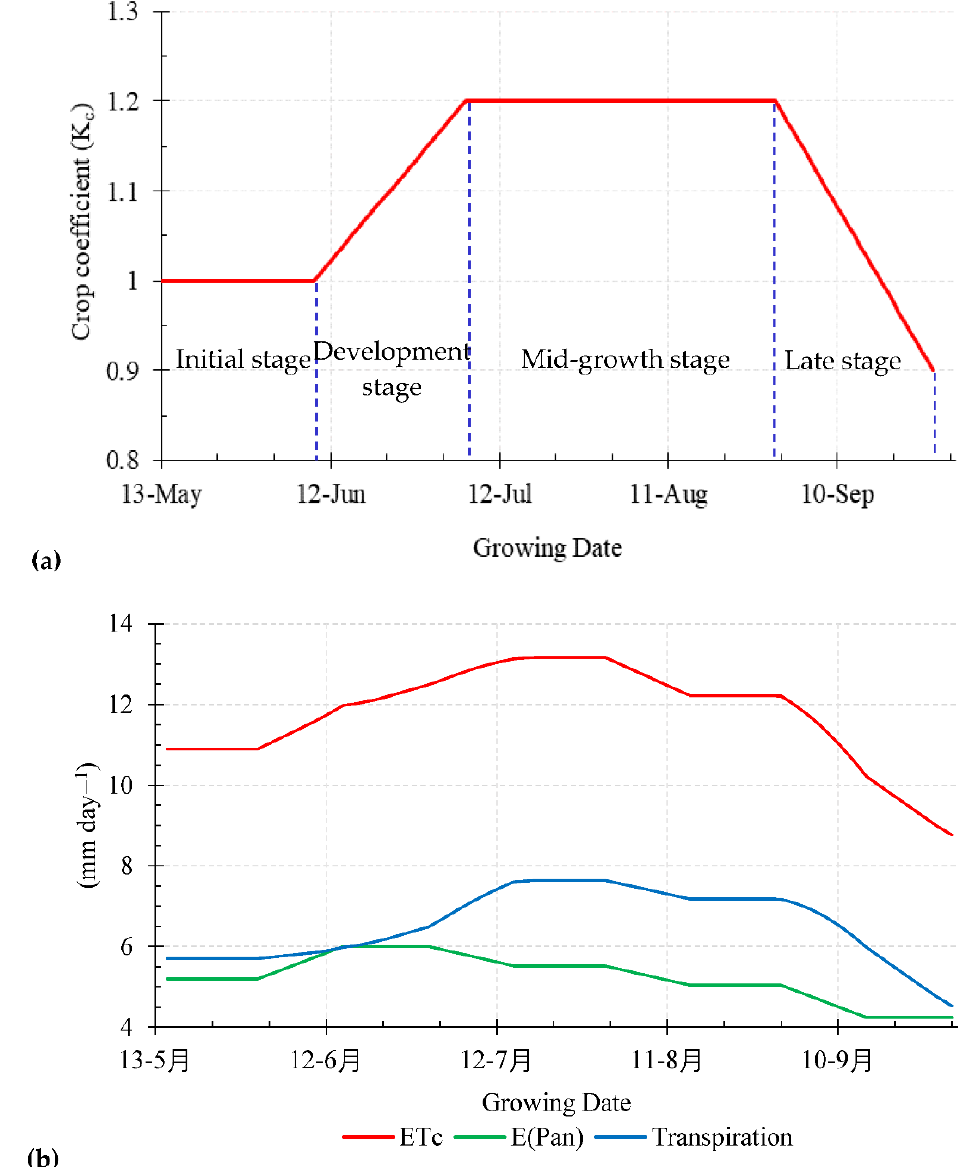
Figure 2. ( a ) Crop coefficients for the different growing stages; ( b ) estimated evapotranspiration (ET C ), evaporation, and transpiration in mm during the growing